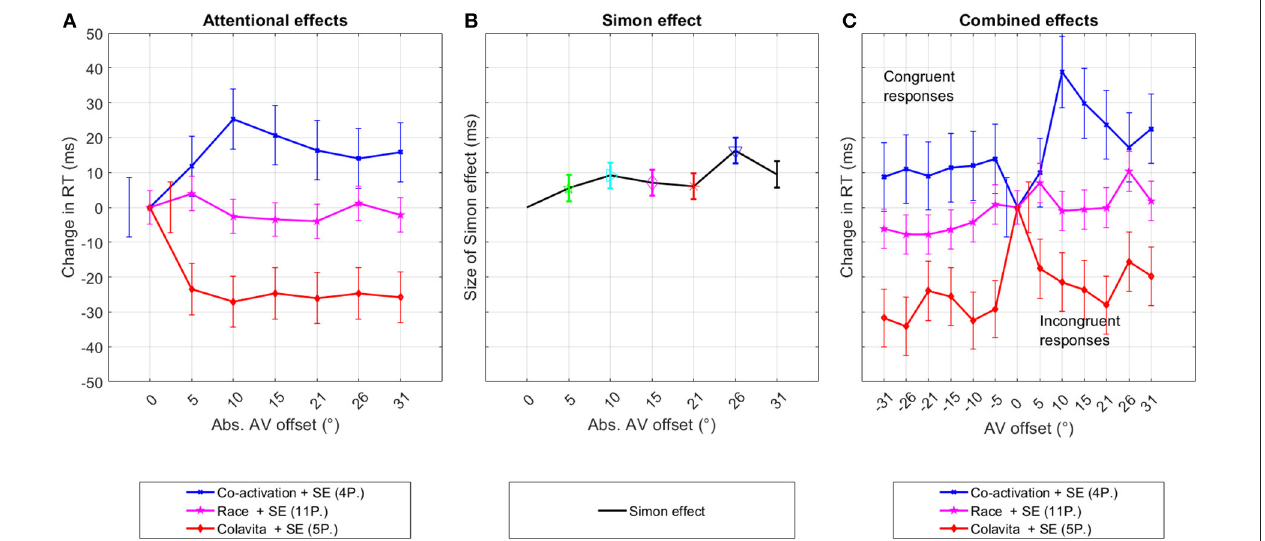
FIGURE 7 | Experiment one—pink noise. This figure shows the decomposition of the original RT distribution into the underlying even and odd components per participant group that were possibly caused by changes in the spatial attention and the Simon effect. The third graph depicts the original distribution of the data sorted into congruent and incongruent responses. The graphs show the changes in mean RTs between data from 0 ◦ and data at offsets in (A, C) , and as the difference in RTs between congruent and incongruent responses (B) . The bars indicate the standard error.